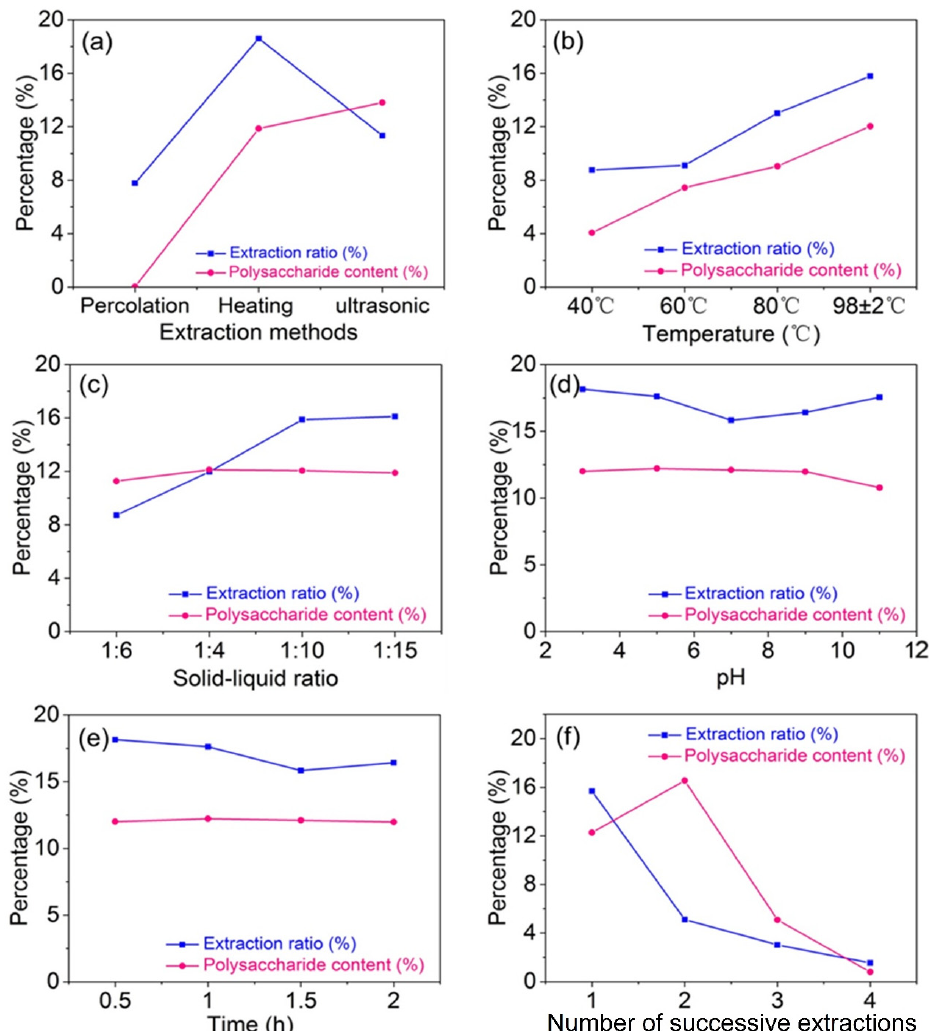
Figure 1. Effects of ( a ) extraction methods, ( b ) temperatures, ( c ) solid–liquid ratios, ( d ) pH, ( e ) extraction time, and ( f ) number of successive extractions on polysaccharide extraction.